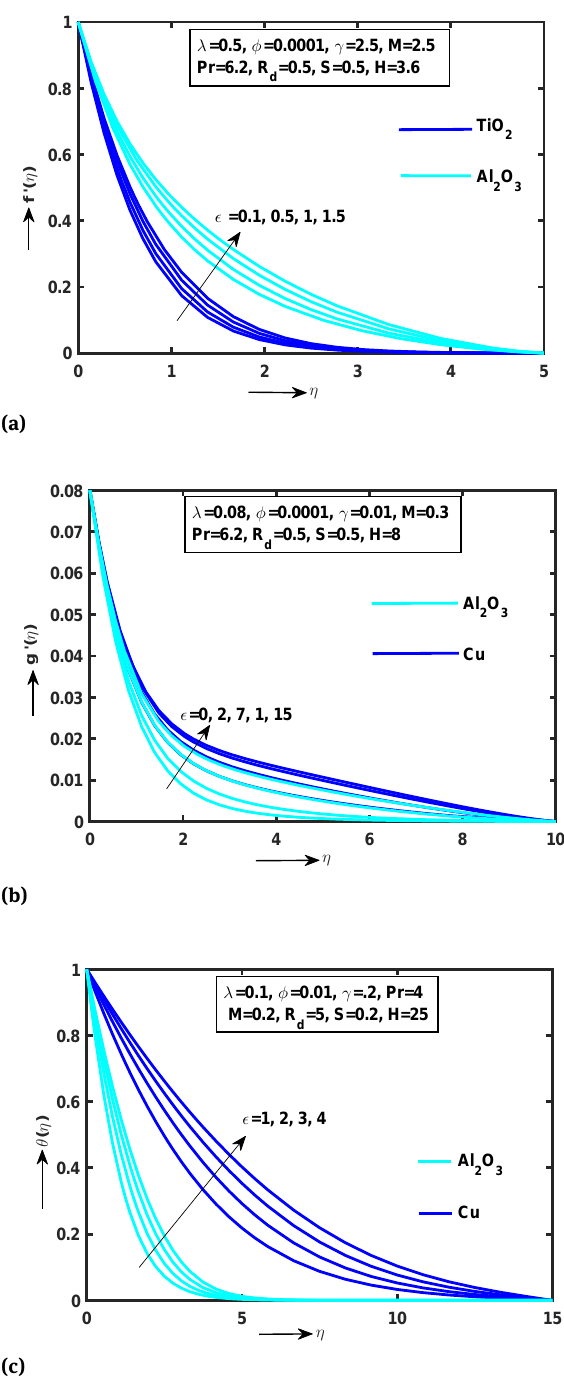
Figure 8: (a) Significance of ϵ on f (cid:48) ( η ) (b) Significance of ϵ on g (cid:48) ( η ) (c) Significance of ϵ on θ ( η